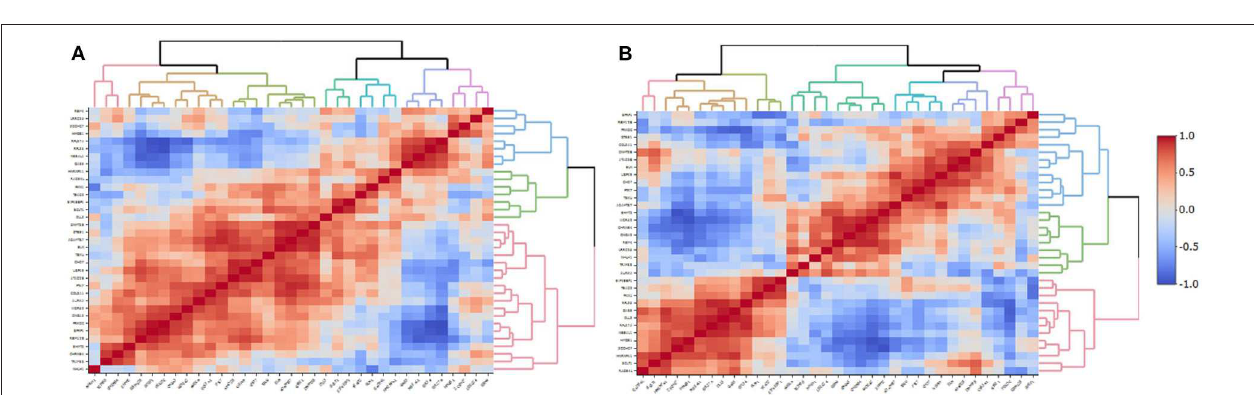
FIGURE 5 | Genes interactions of the amygdala 5-HTT co-expression network. The border of the genes represents the out-degree of these nodes, meaning the number of outgoing relationships. The larger the border, the stronger the relationship of the gene to other genes. The size of the nodes represents the in-degree, i.e., the number of incoming relationships with neighbors. The bigger the node, the higher the relationships of other genes to the target gene. The edges represent co-expression. Color and thickness were used to identify the most co-expressed genes, darker, and thicker represent higher co-expression.